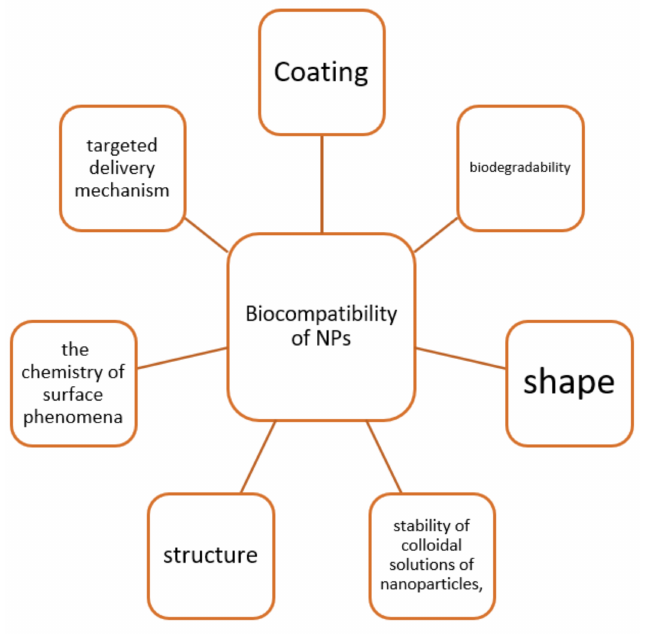
Figure 2. Chosen properties determining the biocompatibility of